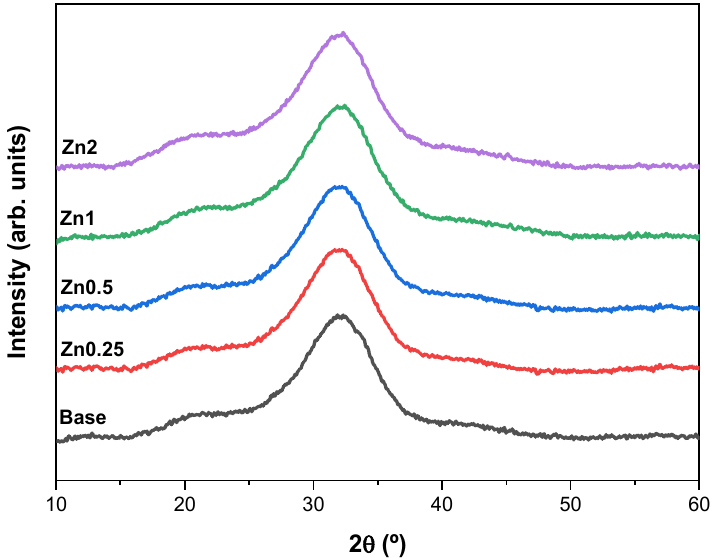
Figure 1. XRD diffractogram of the base Bioglass ® and the bioactive glasses with different concentra- tions of zinc (0.25, 0.5, 1 and 2 wt%).